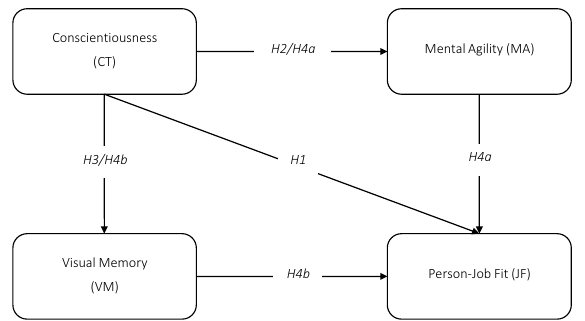
Figure 1. Correlational model